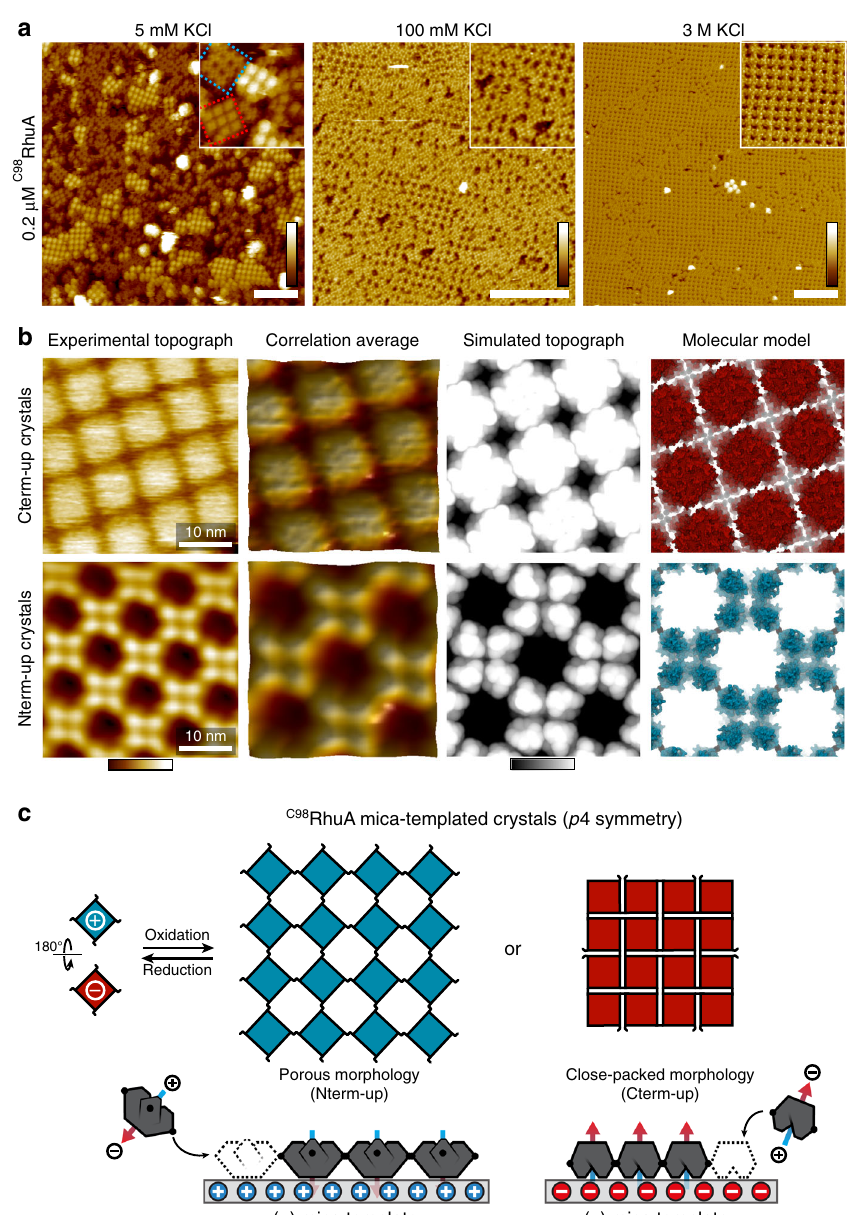
Fig. 2 Surface-templated self-assembly of p 4 C98 RhuA crystals. a Growth of monolayer C98 RhuA crystals on m -mica under increasing [K + ]. Scale bars (white) are 100 nm. Height ranges (gradient): 20 nm, 10 nm, 10 nm (left to right). b High-resolution AFM topographs and structural models of mica- templated crystals. Height ranges (gradients): 7 nm (experimental), 3 nm (simulated). c Cartoon overview of mica-templated self-assembly. Blue and red colors represent positive and negative charges,